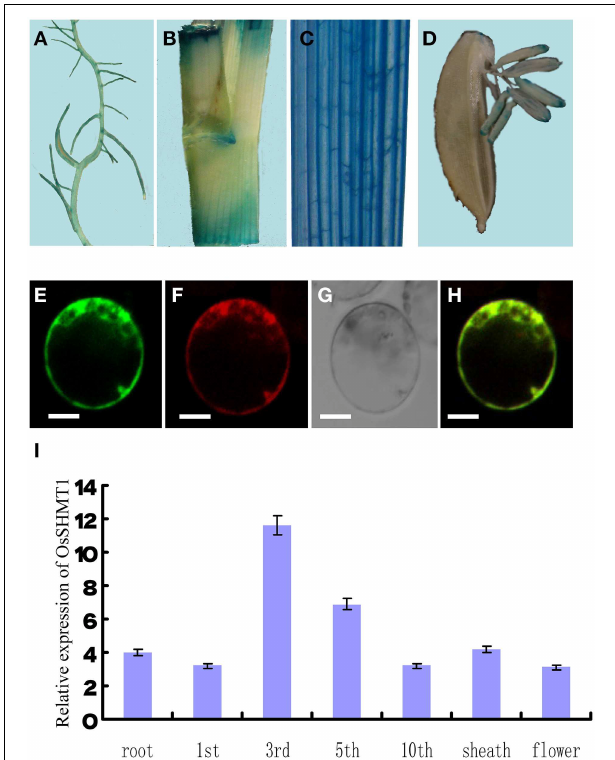
FIGURE 7 | The expression pattern and subcellular localization of OsSHMT1. Different tissues were stained for GUS activity: (A) root; (B) internode; (C) blade; and (D) flower. The subcellular localization of OsSHMT1 was revealed in rice protoplasts as follows. (E) Subcellular localization of the OsSHMT1-GFP fusion protein in rice protoplasts. (F) MitoTracker ® Red. (G) Bright field image of OsSHMT1-GFP. (H) Merged image of (E,F) . Bars = 5 µ m. (I) Quantitative PCR was performed to analyze the expression of OsSHMT1 in root, first leaf, third leaf, fifth leaf, tenth leaf, sheath (mature leaf), and flower.